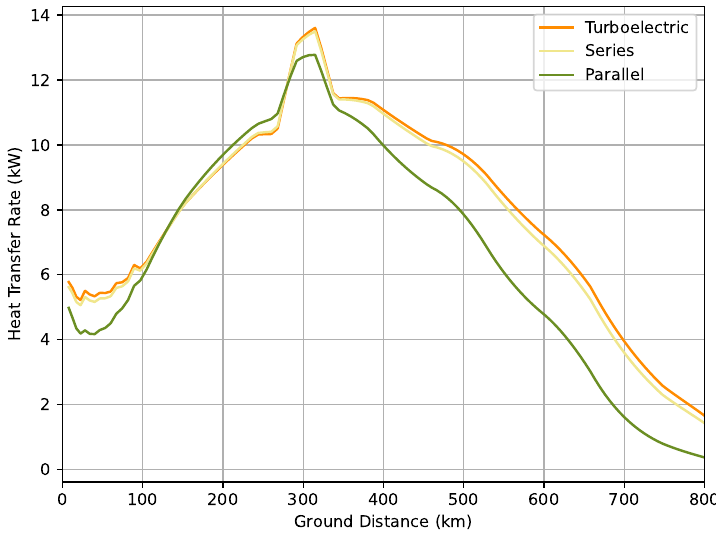
Figure 15. Comparison of the heat transfer rate at the ram air heat exchanger between the three configurations.